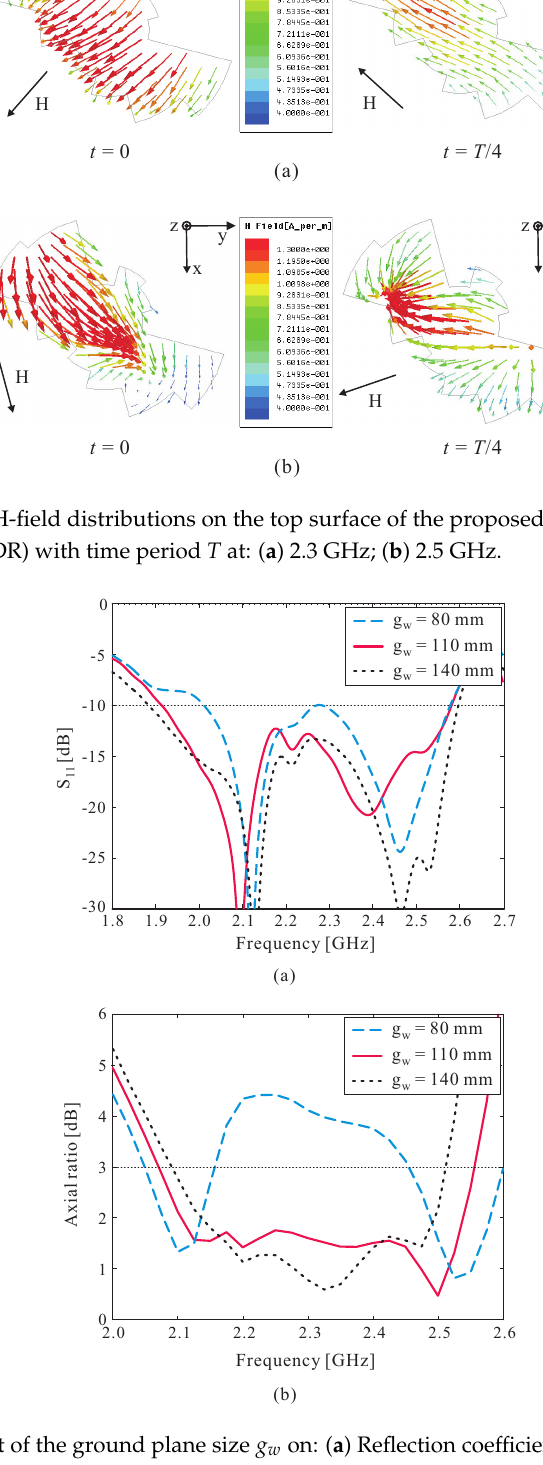
Figure 4. Effect of the ground plane size g w on: ( a ) Reflection coefficient; ( b ) Axial